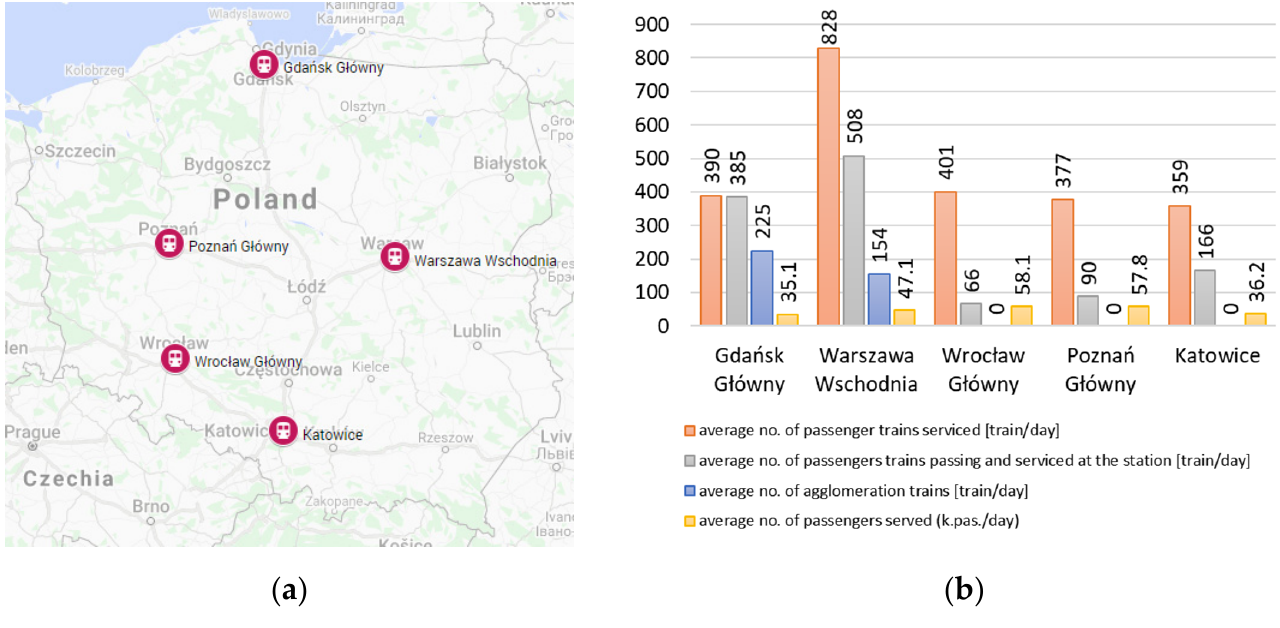
Figure 2. Characteristics of the selected railway stations. (a) Locations of selected railway stations. (b) Characteristics numbers of the selected railway stations. Source: own study based on [37–39]. The train timetable data for the stations listed as of 20 September 2021 were used for the purposes of optimization. An extract of the already compiled data, containing information on train number, train type, arrival time, and departure time, is shown in Table